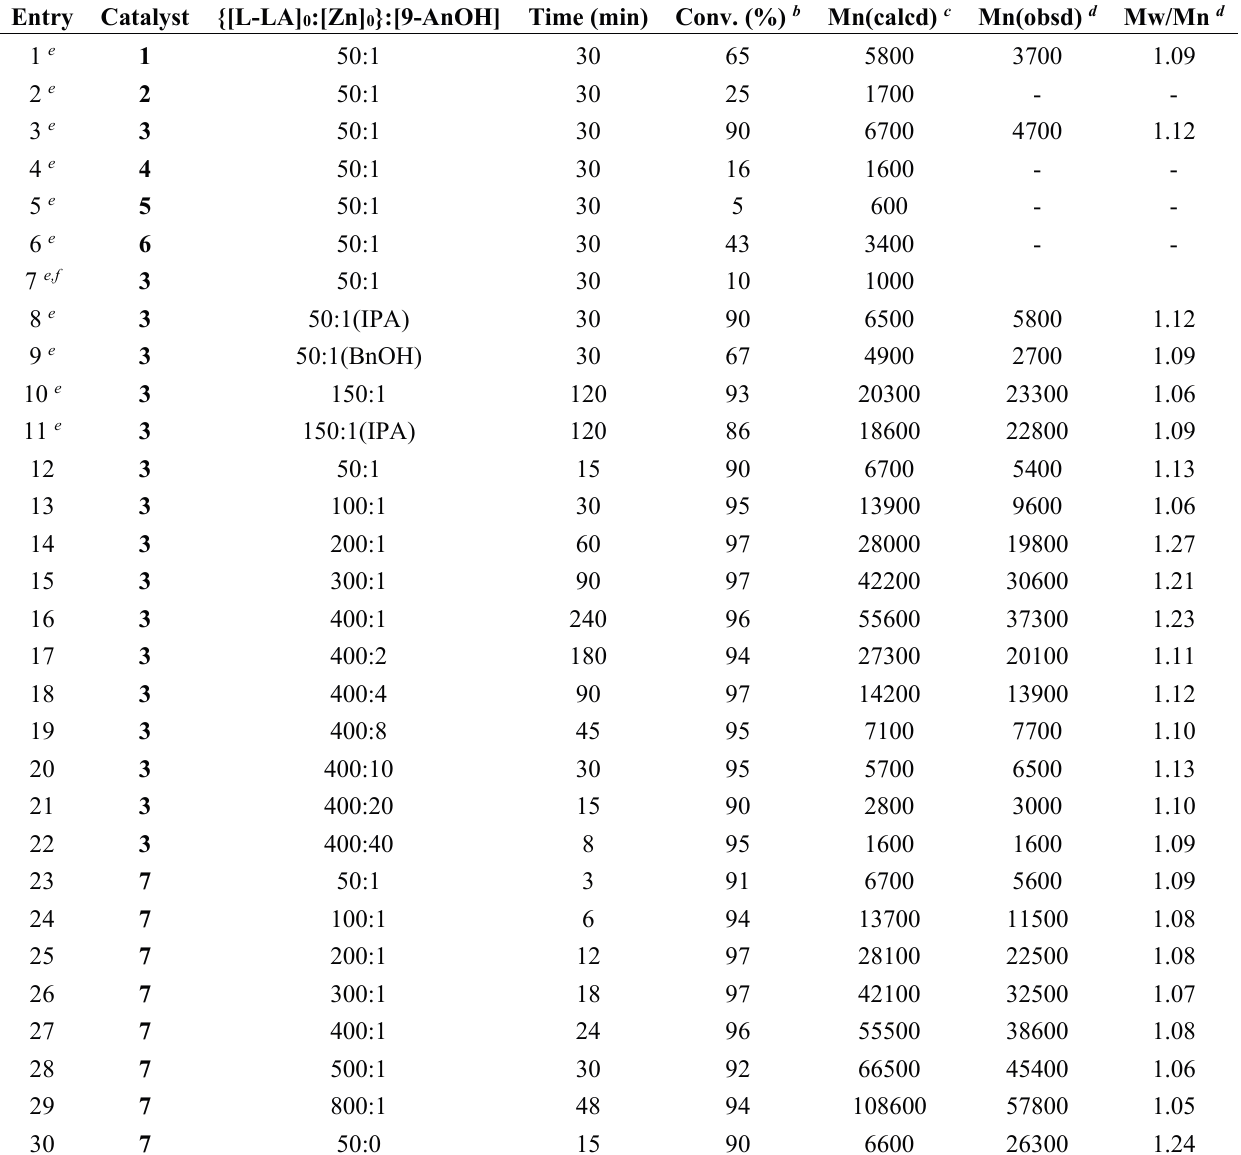
Table 2. Polymerization of L -Lactide Using Compounds 1 – 7 as Catalysts in the Presence of 9-AnOH at 80 °C.